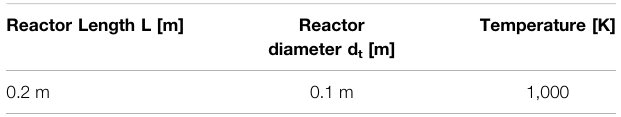
TABLE 1 | Dimensions and operative conditions for the evaluations of current, voltage and resistivity in section Choice of the Support Material for Electri fi ed Structured Reactors